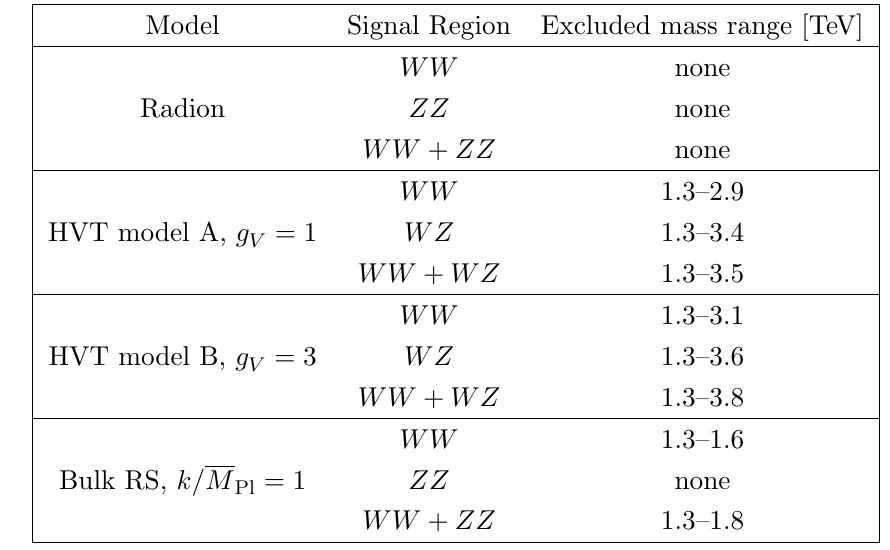
Table 3 . Observed excluded resonance masses (at 95% CL) in the individual and combined signal regions for the HVT, bulk RS and radion